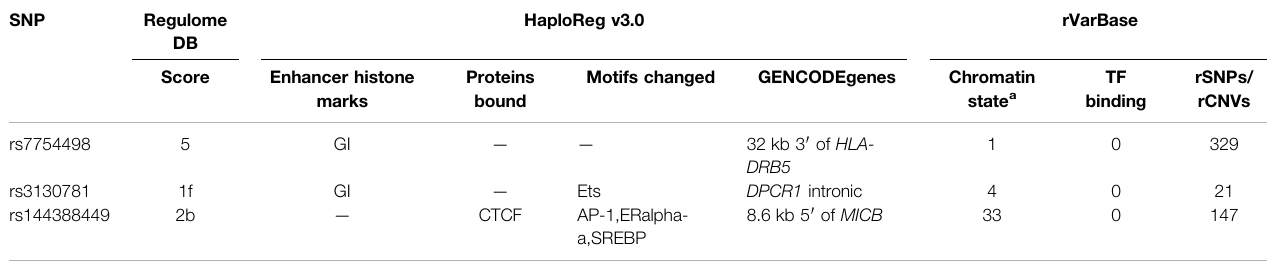
TABLE 2 | Functional annotation from bioinformatics